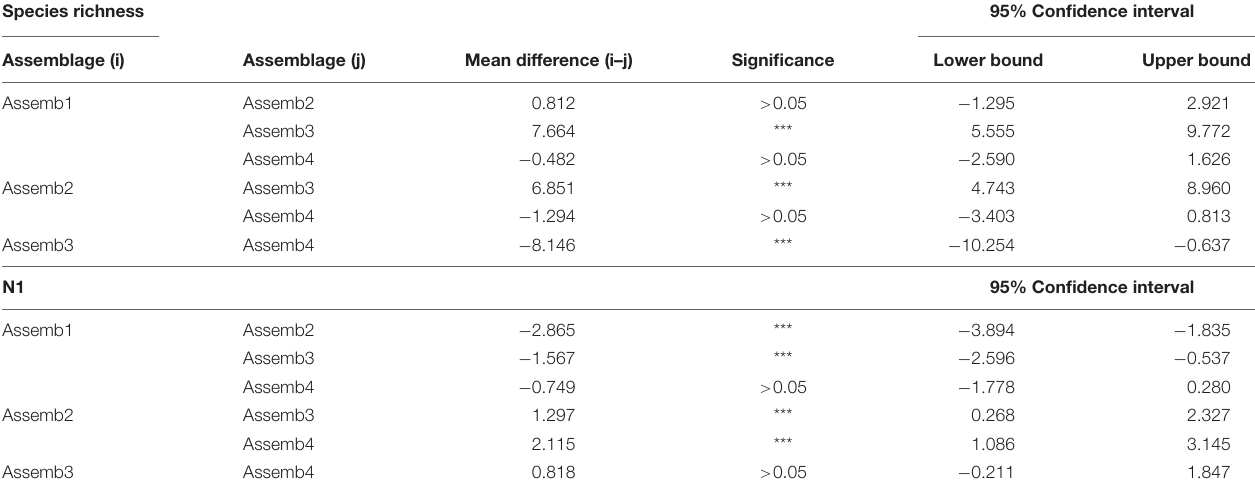
TABLE 5 | Analysis of variance (ANOVA) of diversity indices among Assemblages. Species richness